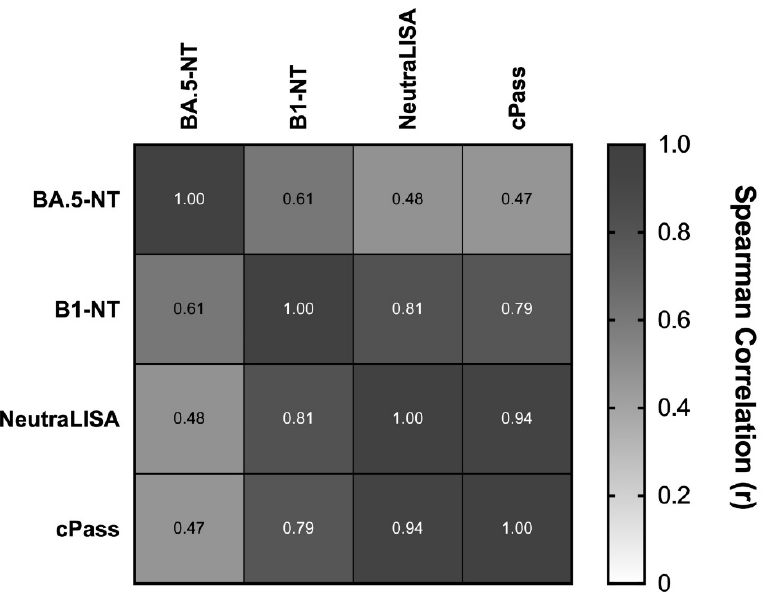
Figure 1. Comparison of virus neutralization capacity of 92 sera obtained six months after vaccination with the original mRNA vaccine (Spikevax, Moderna). Serological neutralization potency was determined by inhibition of the binding of the recombinant, biotin-labelled ACE2-receptor to the recombinant SARS-CoV-2-S1/-receptor binding domain (NeutraLISA, Euroimmun and cPass, Genscript Biotech) or by the endpoints of full-virus dilution neutralization using either the B.1-strain (B.1-NT) or the BA.5.1-strain (BA.5-NT) as targets. R-values of Spearman’s correlation test are shown.